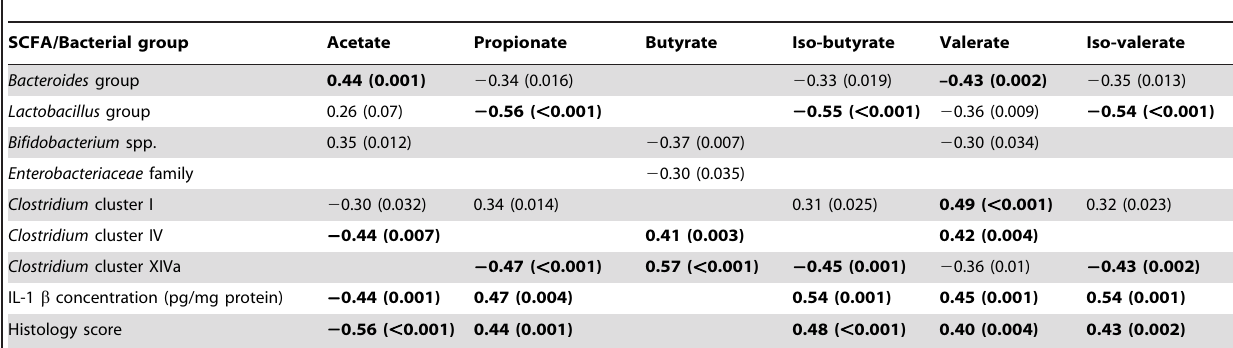
Table 3. Correlations between the cecal parameters SCFA concentration, inflammation markers, and copy numbers of bacterial